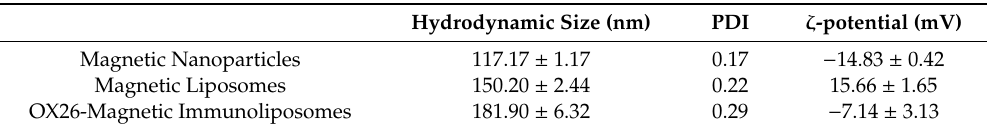
Table 1. Hydrodynamic size, polydispersity index (PDI), and ζ -potential of magnetic nanoparticles, magnetic liposomes, and magnetic OX26